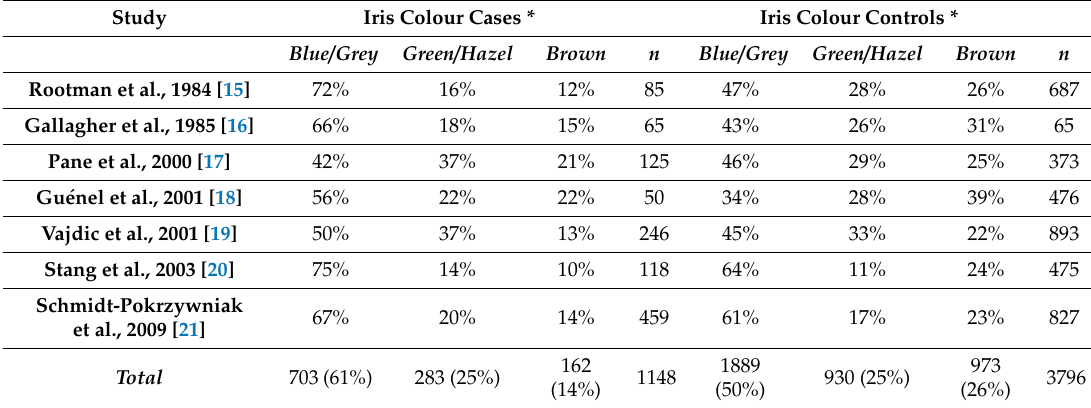
Table 2. Iris colour distribution of Uveal Melanoma cases and controls from other studies.